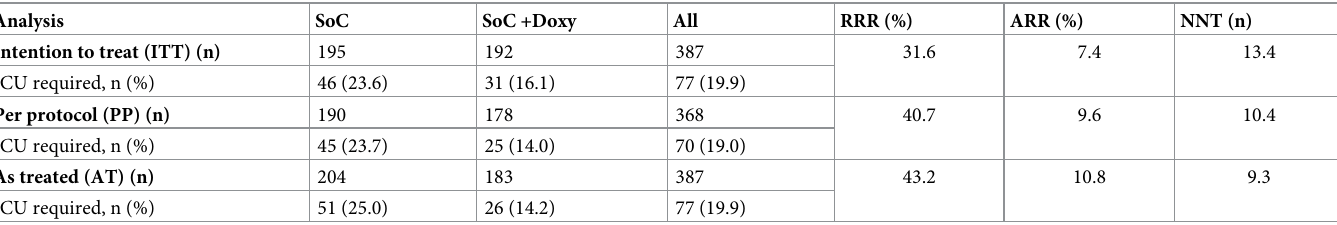
Table 2. Relative Risk Reduction (RRR), Absolute Risk Reduction (ARR) and Number Needed to Treat (NNT) according to the three primary outcome analyses.